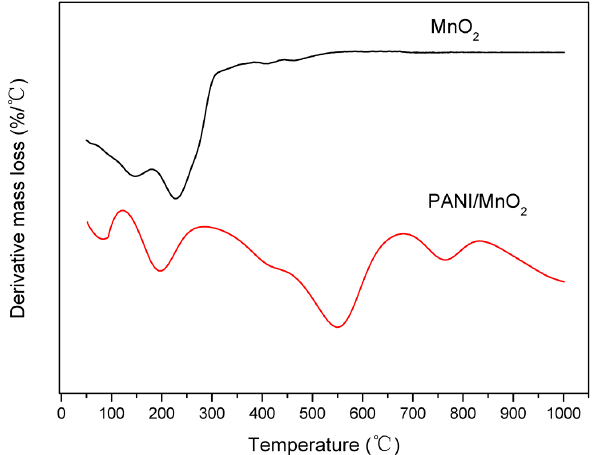
Figure 5. DTG curves of MnO 2 and PANI/MnO 2 .